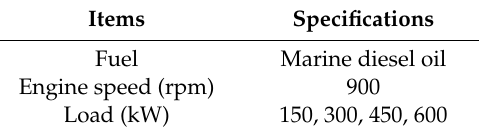
Table 3. Experimental conditions.